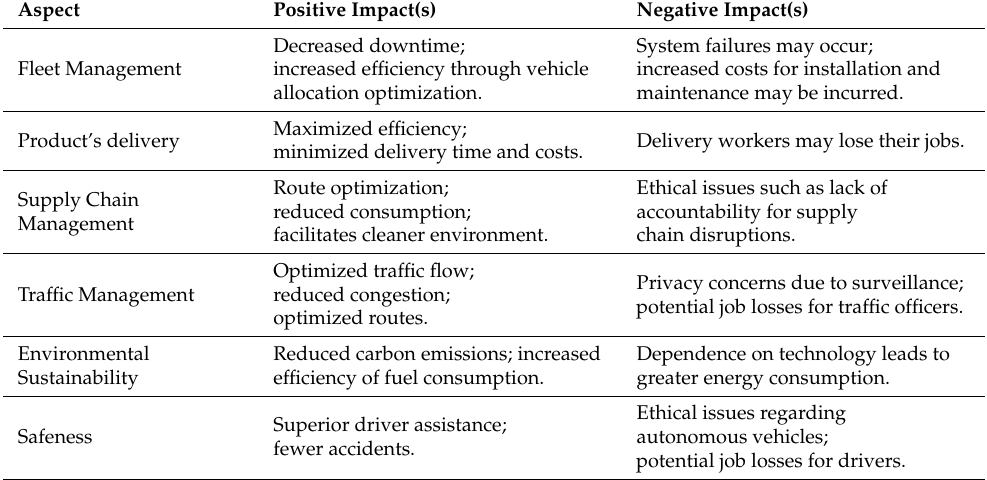
Table 6. The positive and negative impact of AI as a disruptive tool on L and